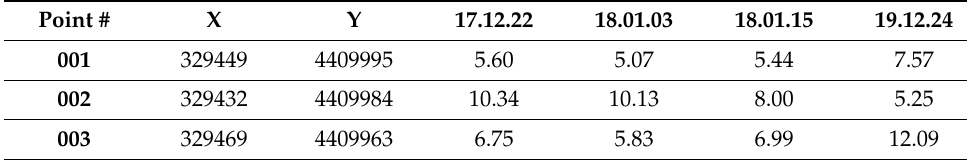
Figure 5. The SOM algorithm, as used in our framework. Table 2. Input layer for SOM